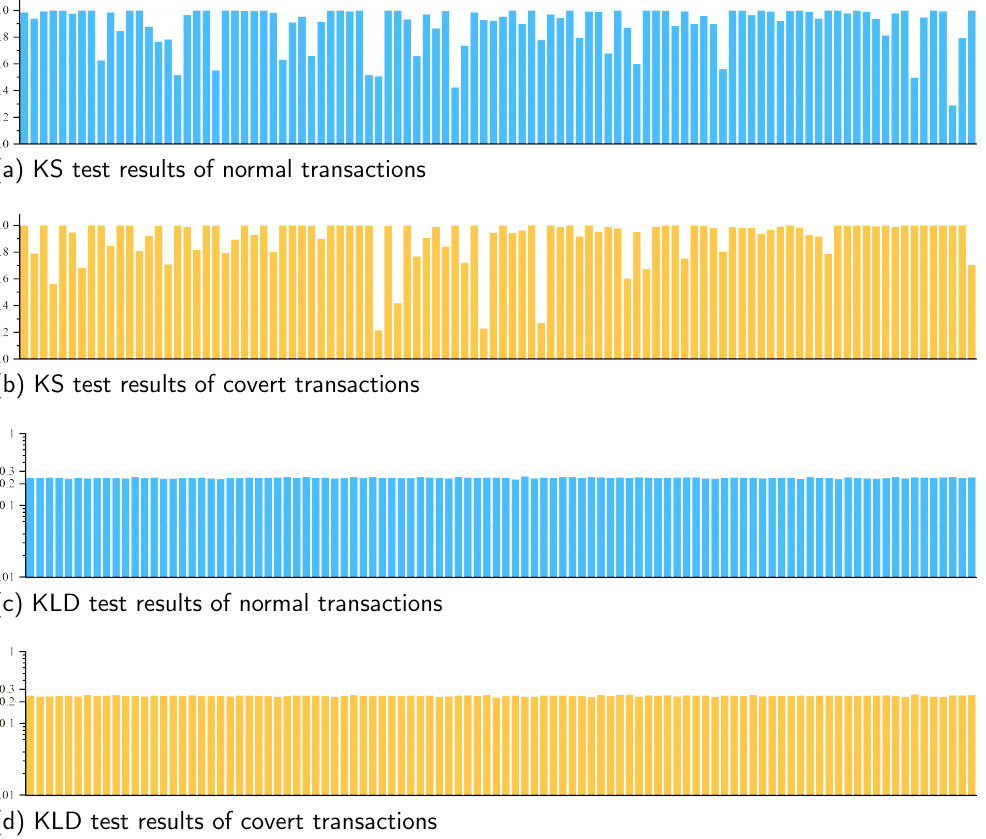
Figure 2. KS and KLD test results of normal transactions and covert transactions.